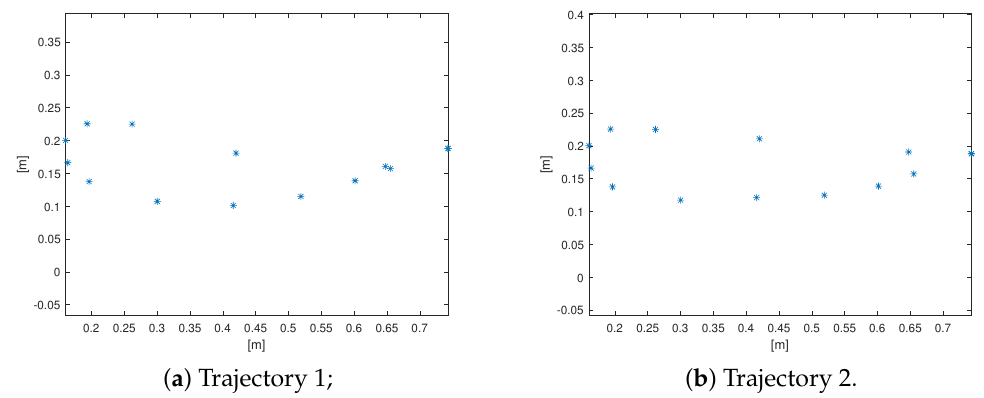
Figure 4. four–bar linkage precision points for the synthesis process.